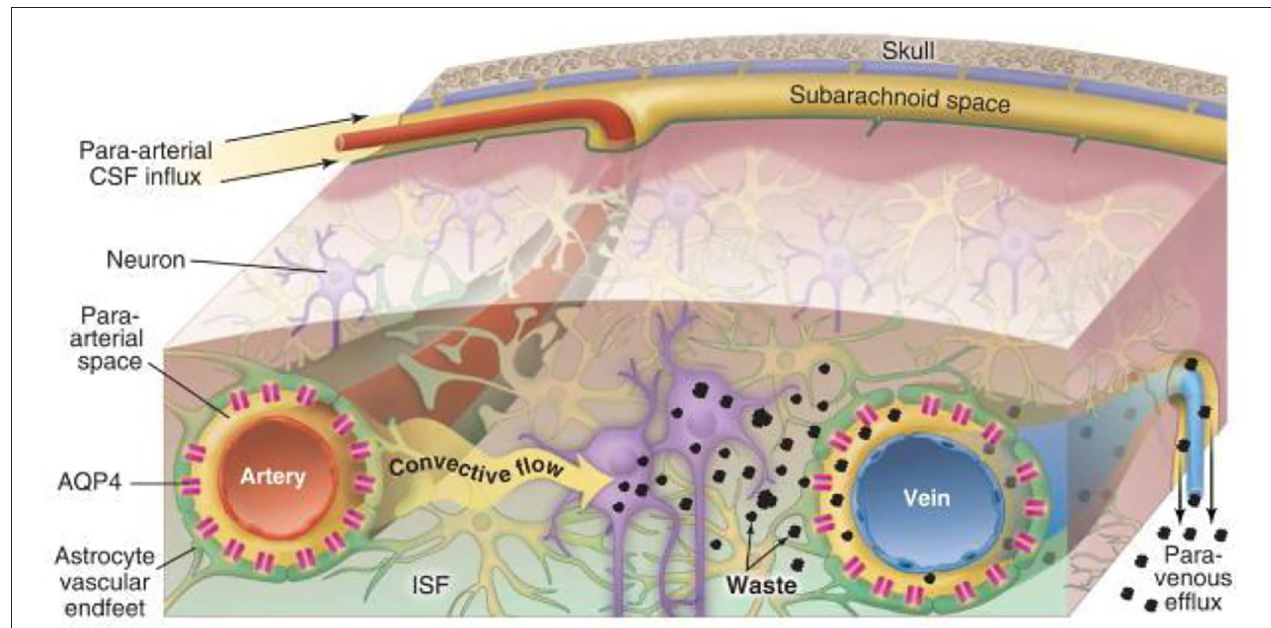
FIGURE 1 | Schematic diagram of glymphatic transport in the brain (8). Cerebrospinal fluid (CSF) influx flows through the peri-arterial space via pulsation of the arterial wall and is then mediated by astrocyte aquaporin 4 (AQP4) in the brain parenchyma, which drives the interstitial fluid (ISF), whereby parenchymal metabolic waste substances exchange with the CSF to efflux into the peri-venous space. Eventually, the waste is cleared into the peripheral lymphatic system of the neck by arachnoid granulations and meningeal lymphatic vessels along with cranial and spinal nerve